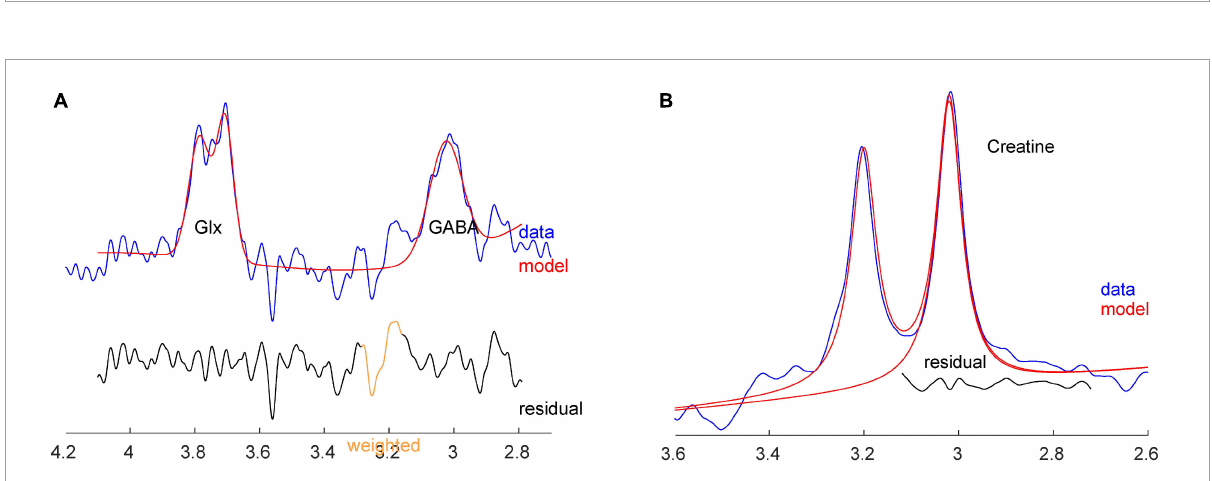
FIGURE3 (A) Sample GABA+ and Glx spectra with fit from Gannet, from the same subject. (B) Sample Cr spectrum with fit from